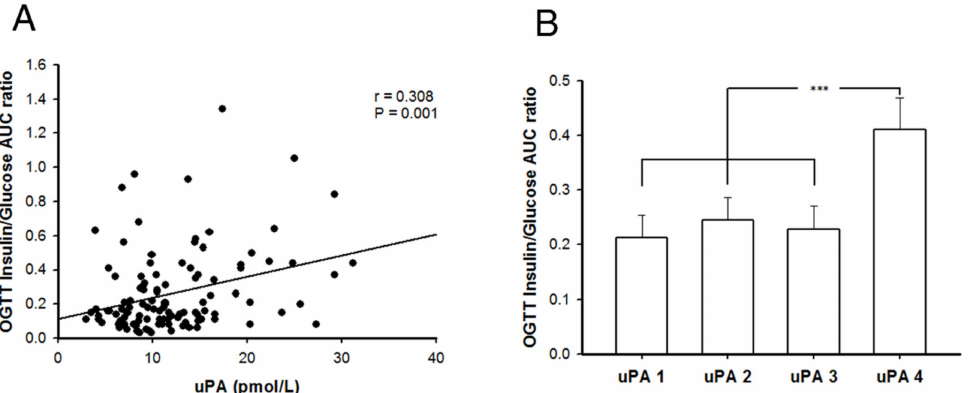
Figure 6. The correlation between uPA and insulin secretion in patients with T2DM. ( A ) The uPA levels showed a weak and significant linear relationship with insulin secretion in patients with T2DM. (r = 0.308, p = 0.001; Pearson’s correlation) ( B ) Patients with T2DM were divided into quartiles